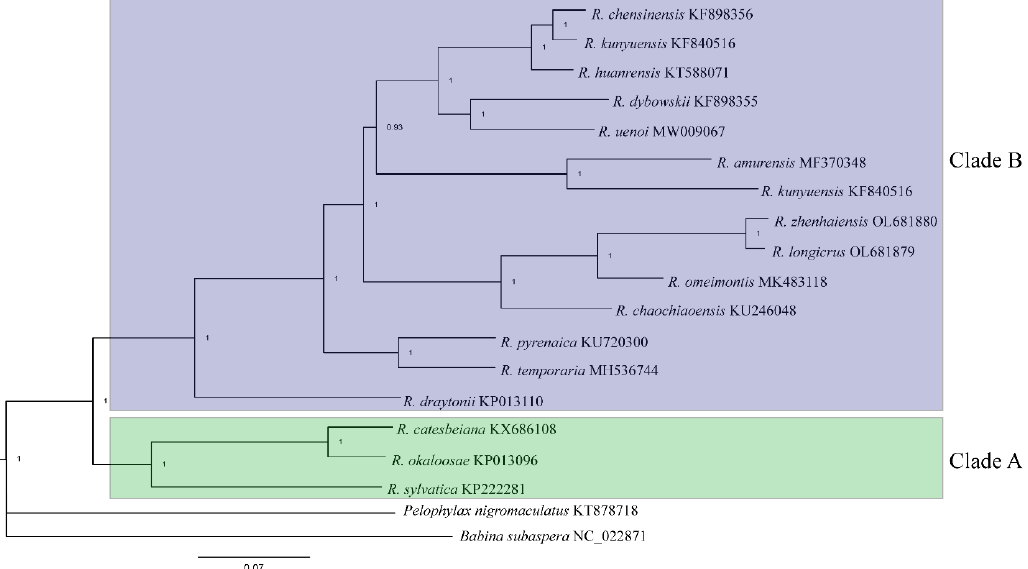
Figure 4. Phylogenetic tree using Bayesian inferences (BI) analyses based on mitochondrial genes (concatenated by 13 PCGs and 2 rRNAs). Posterior probabilities right to the nodes.